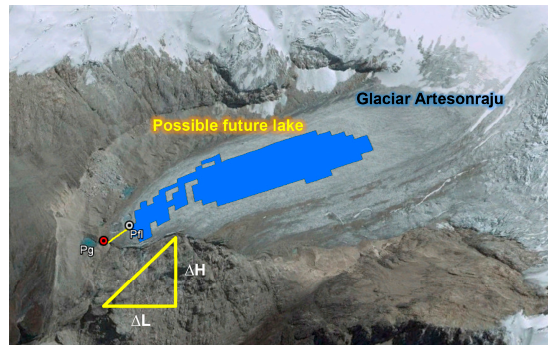
Figure 7. Calculating the time of initial lake formation at Glaciar Artesonraju; P g : the lowest point of the glacier where H = H min in the glacier inventory, P fl : the point of starting lake formation, ∆ L: the length between P g and P fl , and ∆ H: the elevation difference between P g and P fl . Google Earth image of 2003.